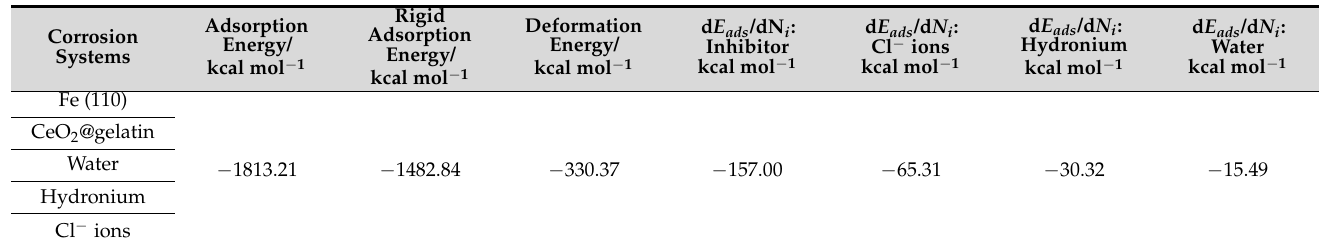
Table 4. Data and descriptors computed by the MC simulations for the adsorption of the CeO 2 @gelatin molecule on Fe (1 1